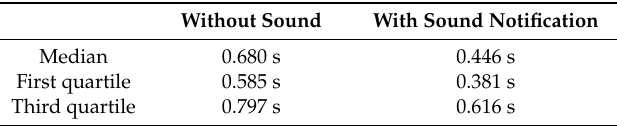
Table 1. Calculated statistics for measured reaction times.